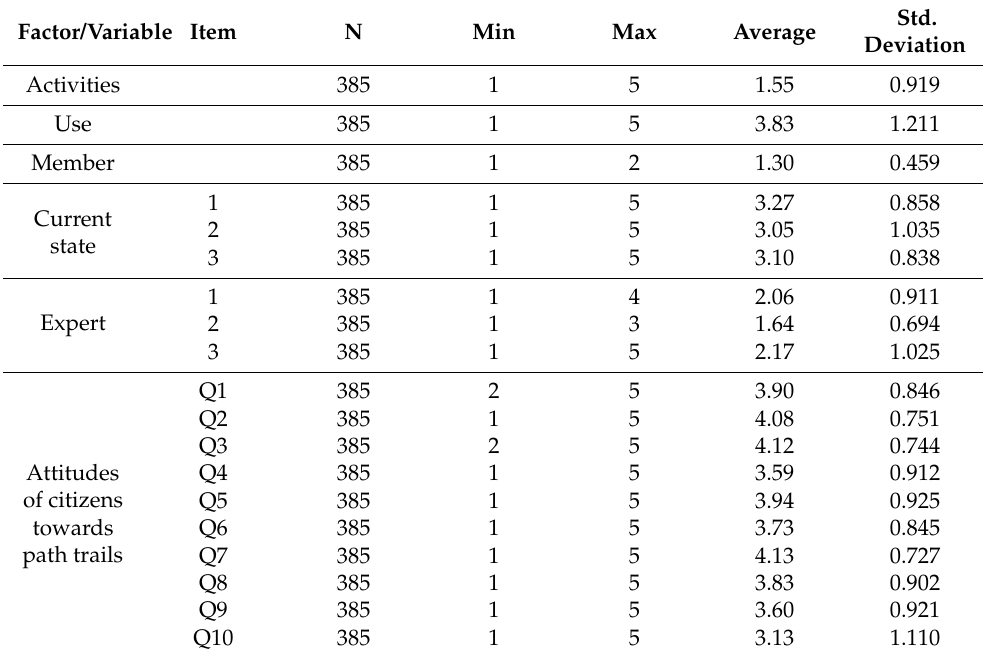
Table 4. Descriptive statistics (min, max, average, standard deviation) for the factors and observed items were used for the structural equation modeling.